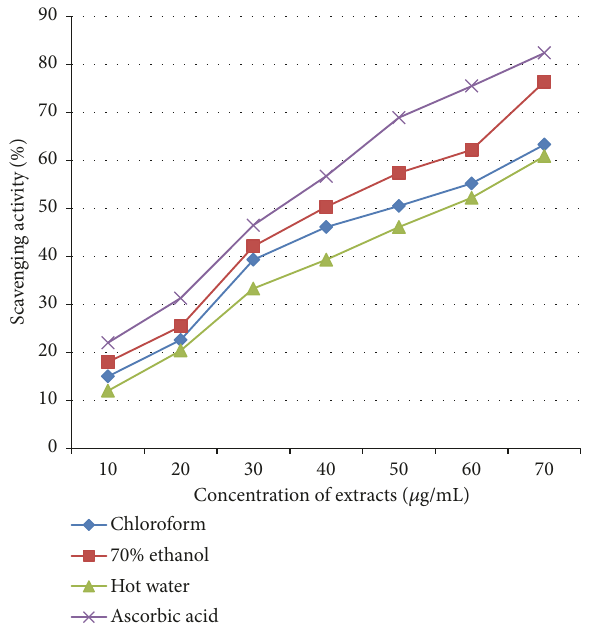
Figure 3: Free radical scavenging activities of Auricularia extracts.